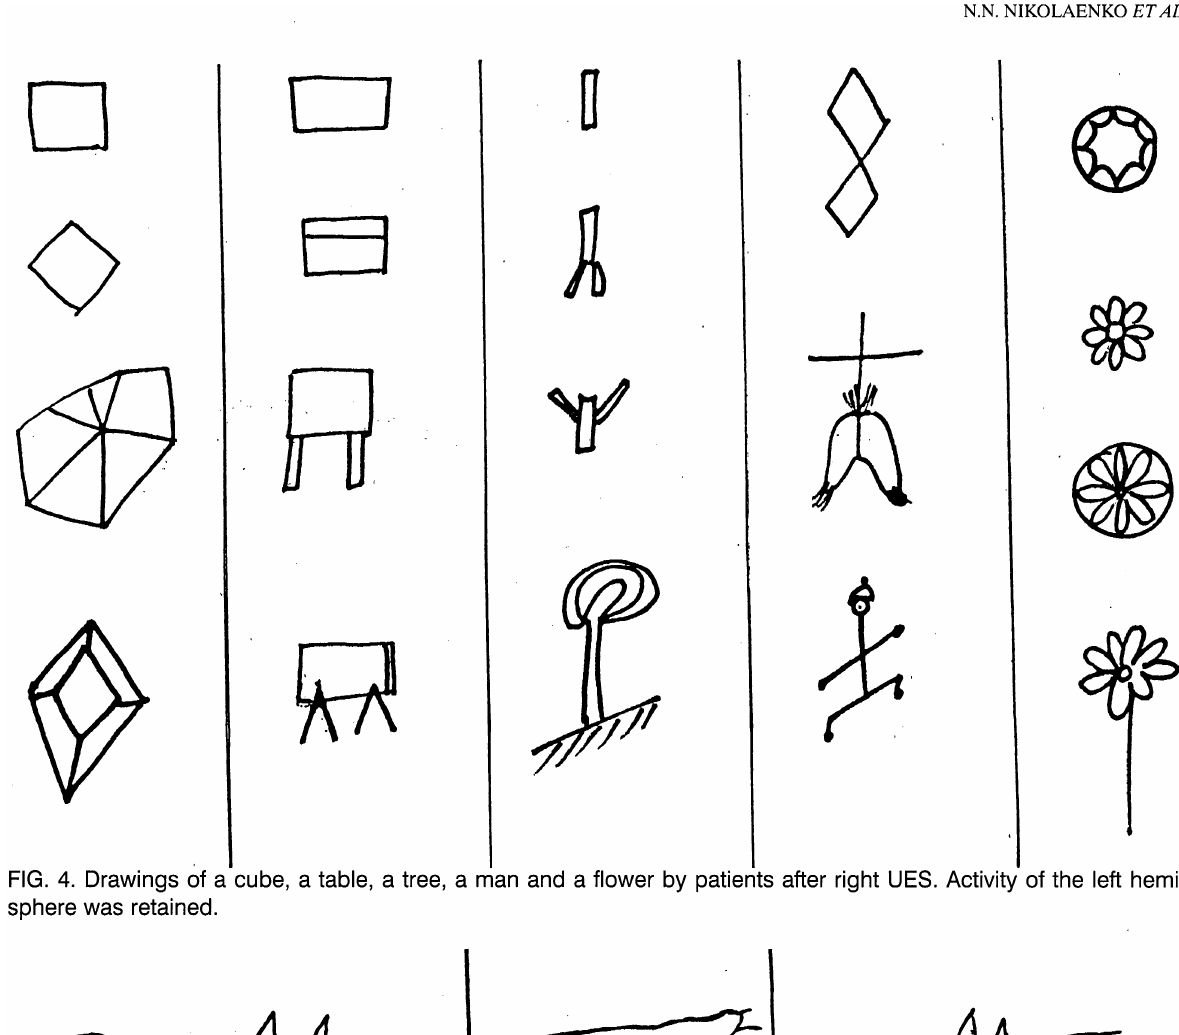
FIG. 4. Drawings of a cube, a table, a tree, a man and a flower by patients after right UES. Activity of the left hemi sphere was retained.